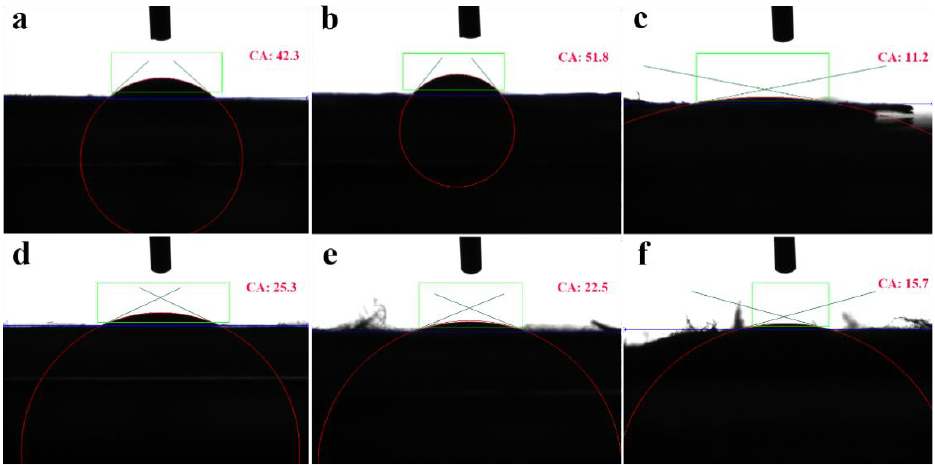
Figure 5. Water contact angle images of composite spinning films: ( a ), PCL/PEO; ( b ), PCL/PEO/CS; ( c ), PCL/PEO/CTAB 1 ; ( d ), PCL/PEO/CS/CTAB 0.2 ; ( e ), PCL/PEO/CS/CTAB 0.4 ; ( f ), PCL/PEO/CS/CTAB 0.6 .